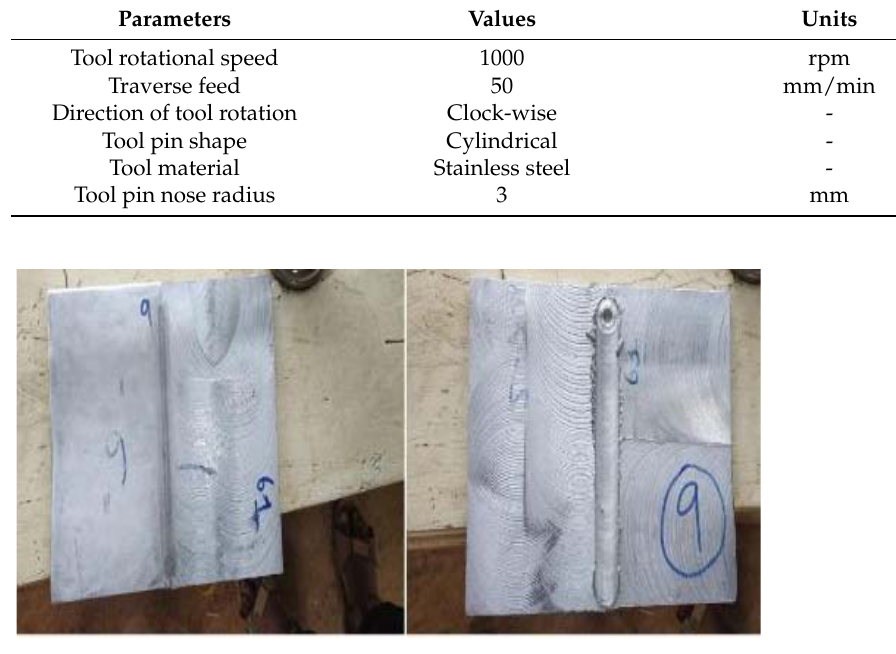
Figure 1. Friction Stir Welding specimens.